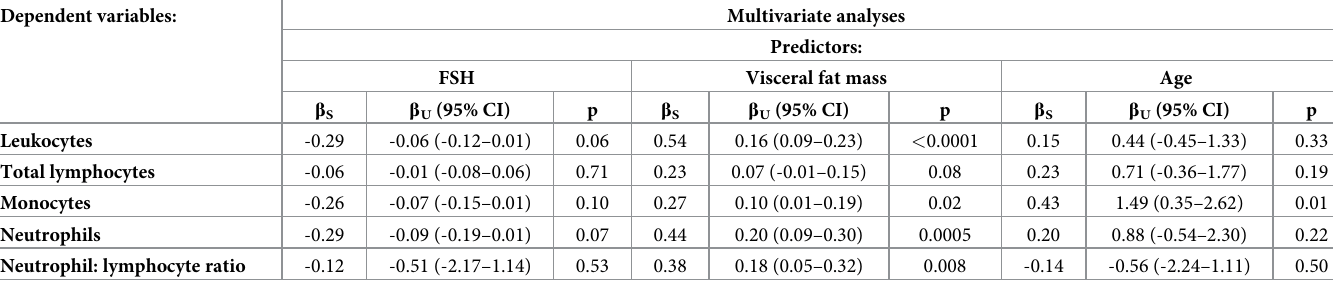
Table 3. Multivariate regression analyses of predictors of white blood cell counts. Dependent variables: